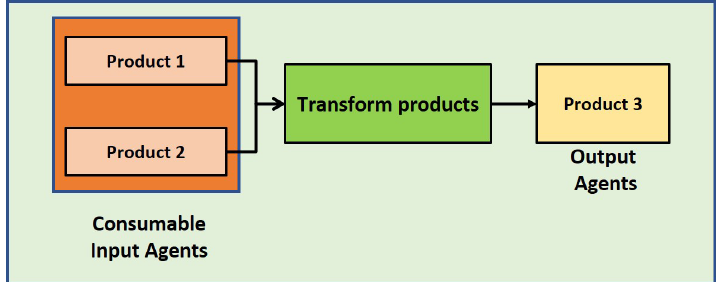
Figure 10. Transform-Product